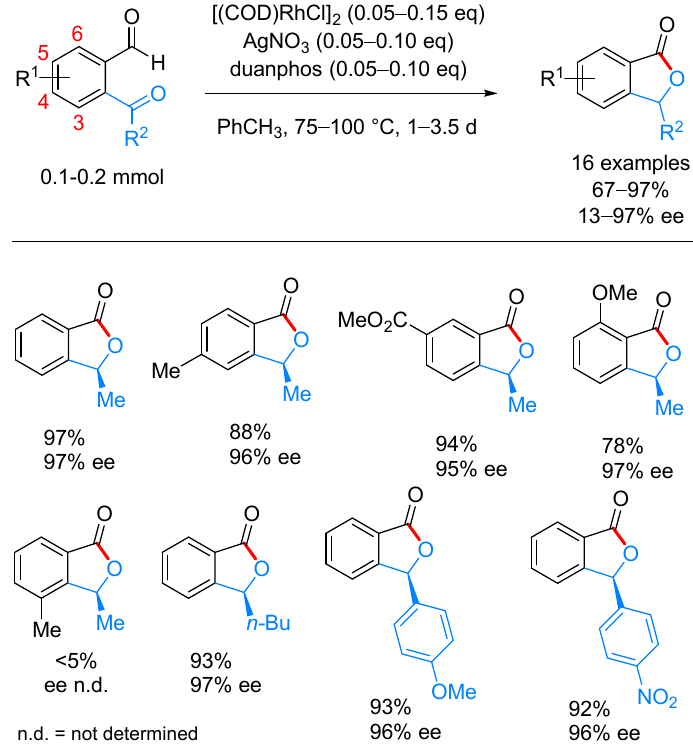
Scheme 38. Rh-catalyzed hydroacylation of o -ketobenzaldehydes for the synthesis of 3-substituted